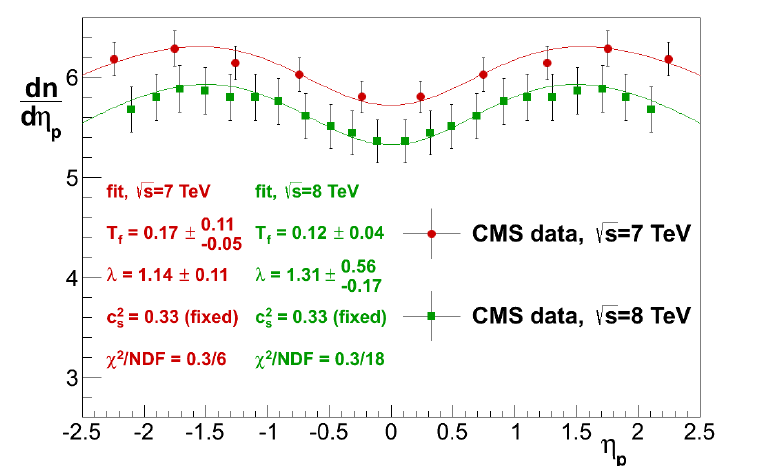
√ s = 7 and 8 TeV p + p